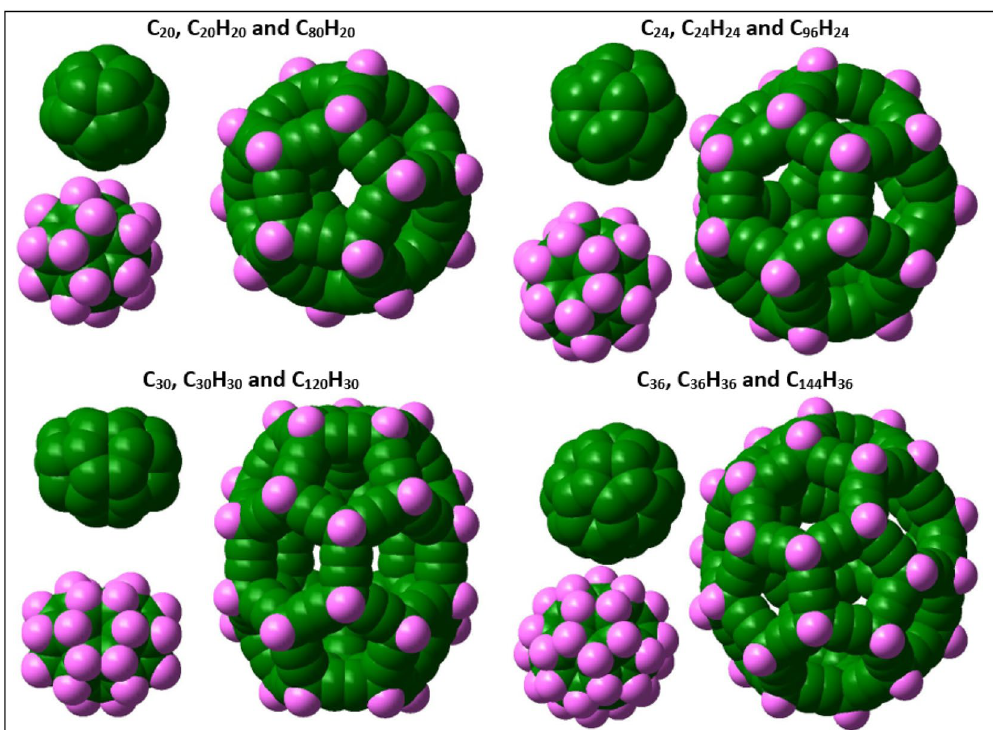
Figure 6. For better visualization and comparison of fullerenes (C n ), fulleranes (C n H n ) and fullerynes (C 4n H n ) with each other, the graphic models are presented. The symmetry of the fullerane and fulleryne structures is higher than the symmetry of the fullerene structures, and ignoring about